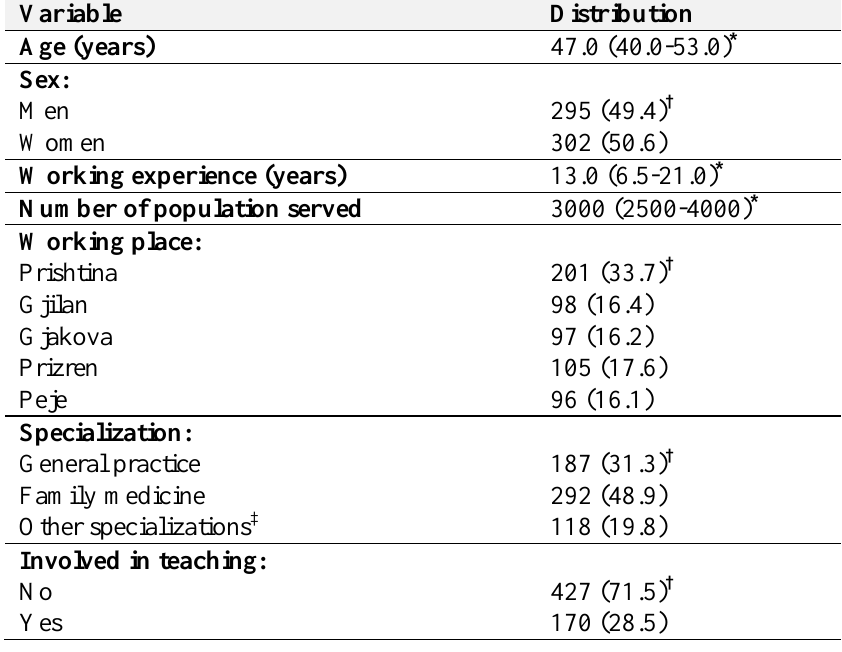
Table 1. Distribution of demographic characteristics, work experience and specialization in a representative sample of primary health care physicians in Kosovo, in 2013